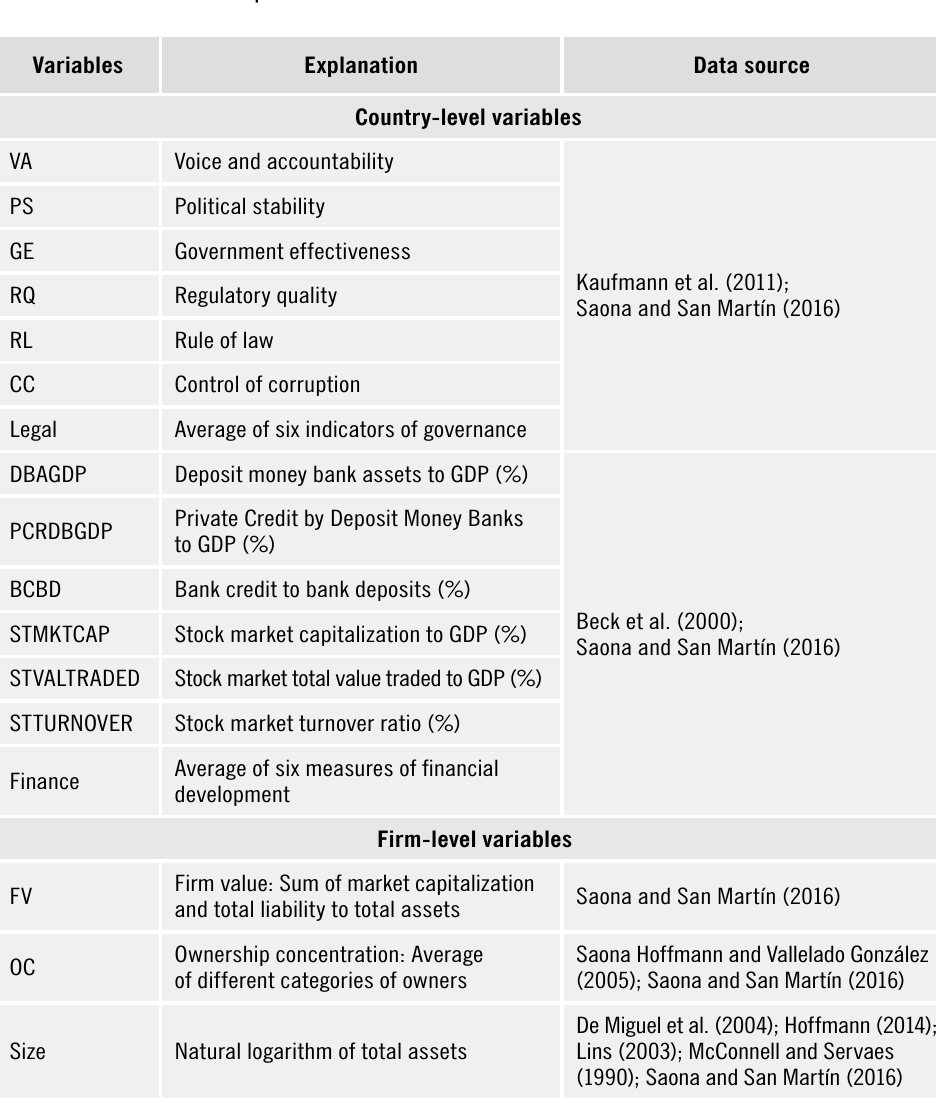
Table 1. Variables